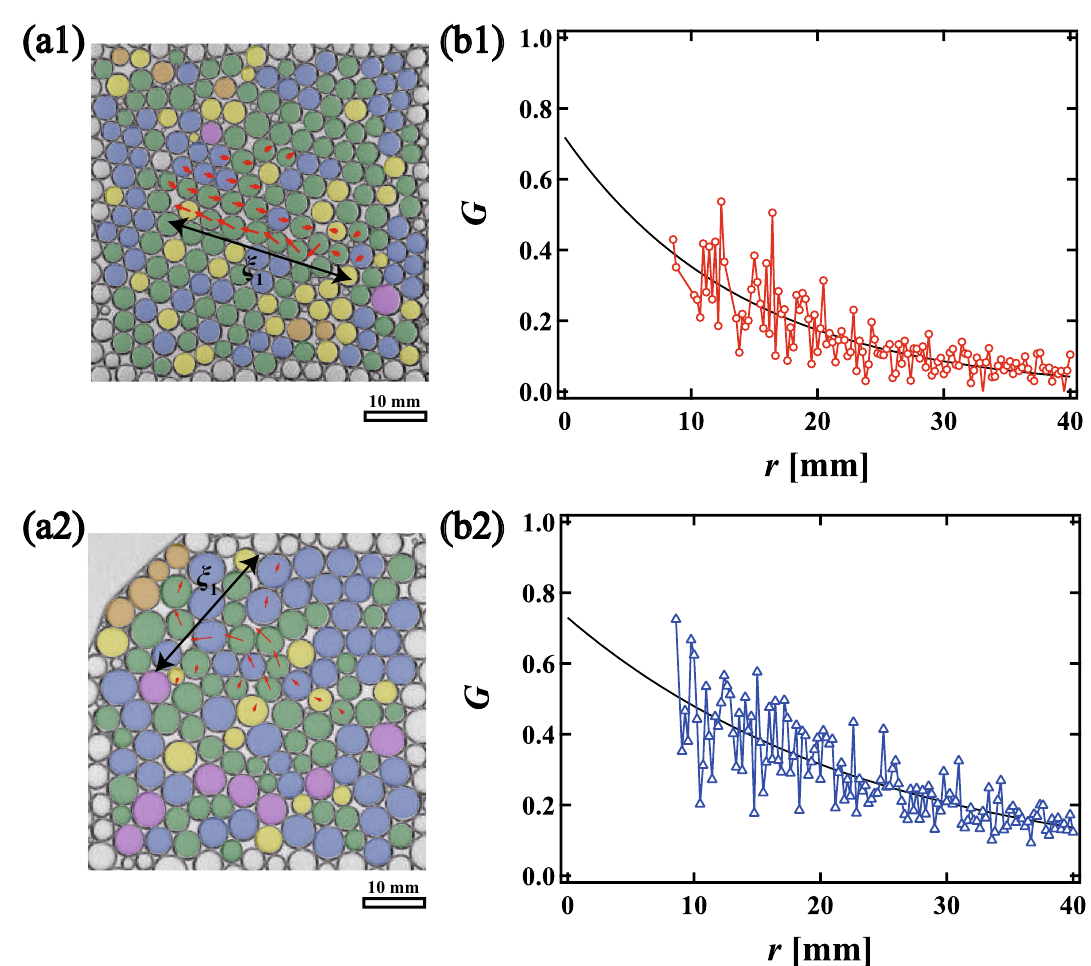
Figure 3. Displacement vector fields of rearranged bubbles in ( a1 ) a monodisperse foam when φ 2 D = 0.11 from 119 s to 278 s and ( a2 ) a polydisperse foam when φ 2 D = 0.093 from 66 s to 146 s. Vectors are shown three times their actual lengths for visibility. ( b1 ) Displacement correlation function G as a function of distance r for the monodisperse foam. ( b2 ) G for the polydisperse foam. The black solid line is an exponential fitting by exp ( r /ξ) . Correlation length (size) ξ 1 is defined as the greatest distance between bubbles in a single collective rearrangement event. We also define ξ 2 as the exponential decay length of G